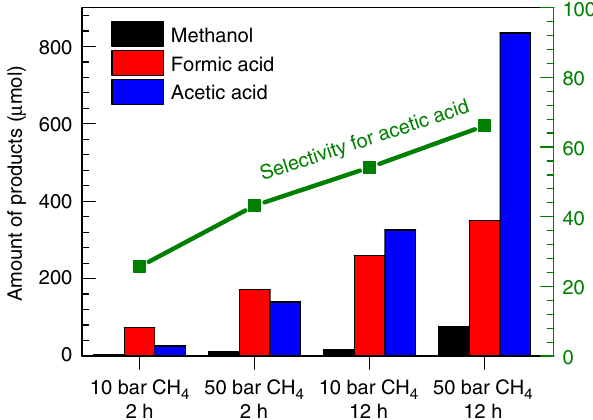
Fig. 2 Catalytic performance of 0.10 wt%Rh/ZSM-5. Yields of acetic acid, formic acid and methanol as well as the selectivity to acetic acid as a function of different pressures of CH 4 (10 or 50 bars) and different reaction times (2 h or 12 h). 28 mg of 0.10 wt%Rh/ZSM-5 was used for each catalysis test. Each catalysis test used 10 bar CO and 8 bar O 2 and certain pressure of CH 4 as noted on x -axis (10 or 50 bars). The